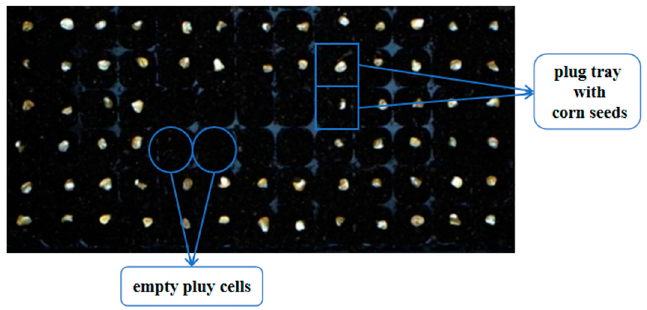
Figure 2. The diagram of partition with empty cells.